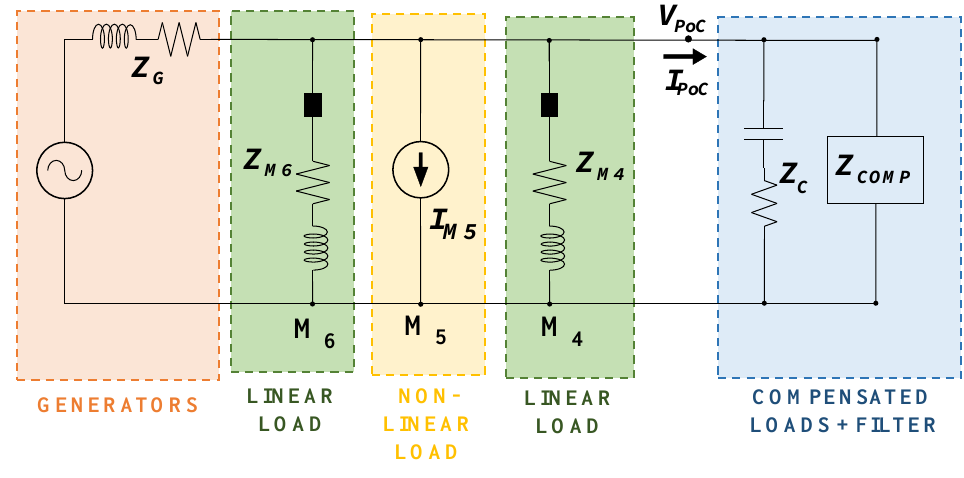
Figure 5. Simplified model of the electric grid of Figure